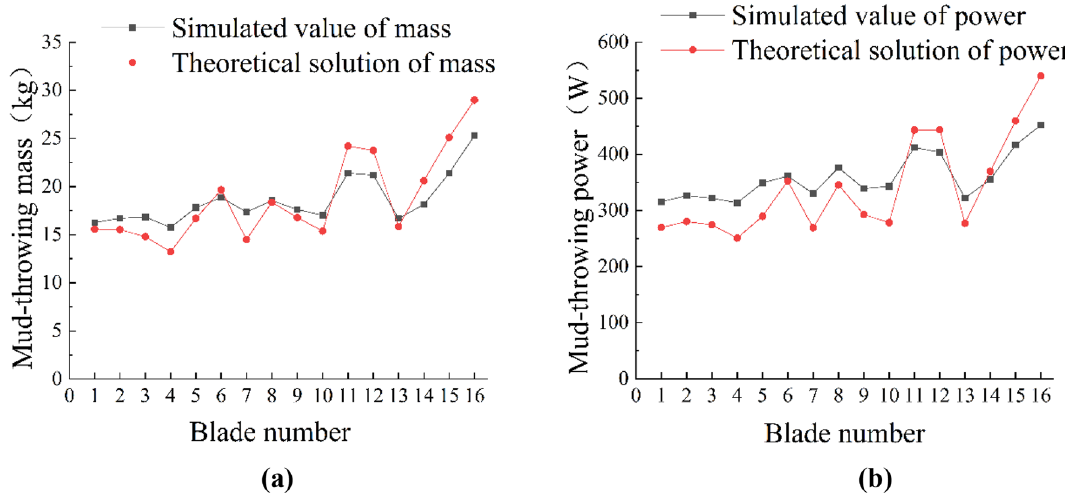
Figure 7. Trend comparison chart. ( a ) Comparison of mud quantity trends; ( b ) comparison of operating power